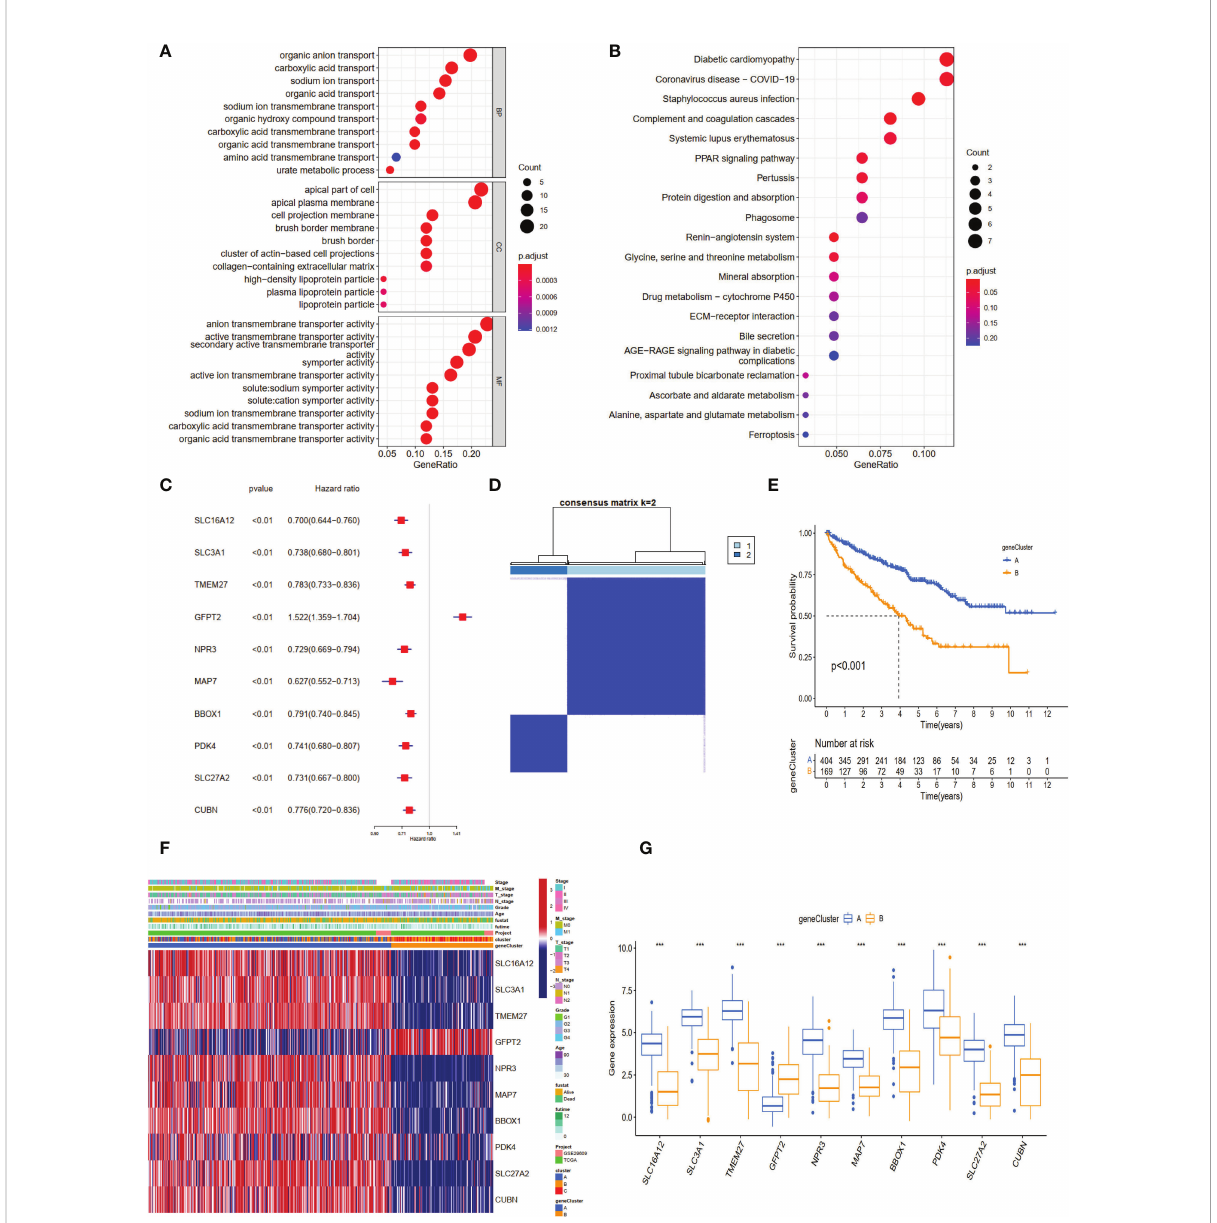
FIGURE 4 The different expression genes (DEGs), enrichment pathways among different clusters, and consensus clustering based on DEGs. (A) The GO and (B) KEGG enrichment of different subtypes. (C) The forest plot for ten core DEGs based on univariate Cox regression analysis. (D) Consensus matrix of ccRCC samples ’ co-occurrence proportion for k = 2. (E) Kaplan – Meier curves for the two gene clusters of ccRCC patients. The log-rank test shows an overall p <0.001. (F) Heatmap showing the relationship among the clinicopathological characteristics of the gene clusters. (G) The boxplot of gene expression of ten core genes between the two subtypes. ***p <